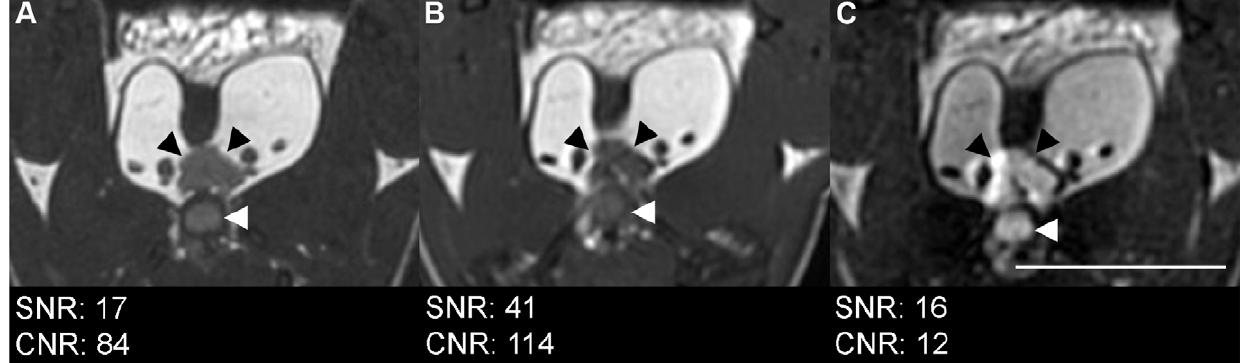
Figure 3. Comparison of in vivo axial views acquired with A: bSSFP, B: T1wSE and C: T2wSW. Black arrows indicate prostate, white arrows indicate urethra. Scale bar is 1 cm. bSSFP images acquired using optimized sequence with 3 6 3 cm FOV. Spin echo sequences acquired with axial orientation, FOV 3 6 3 cm, TR/TE=600/25 ms (T1w), 2000/70 ms (T2w), 1 mm slice thickness, 128 6 128 matrix, 234 mm in-plane resolution, and 20 (T1w) and 17 (T2w) minutes acquisition time.